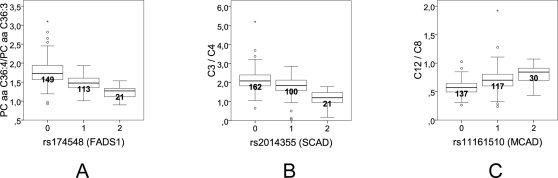
Boxplots of the strongest associations of metabolite concentration ratios with polymorphisms in the FADS1 (A; p = 2.4×10−22), SCAD (B; p = 9.3×10−17), and MCAD (C; p = 7.6×10−17) genes (see legend to
Figure 3 for details).The metabolic efficiencies of the reactions that are catalyzed by these three enzymes differ considerably between individuals of different genotype.